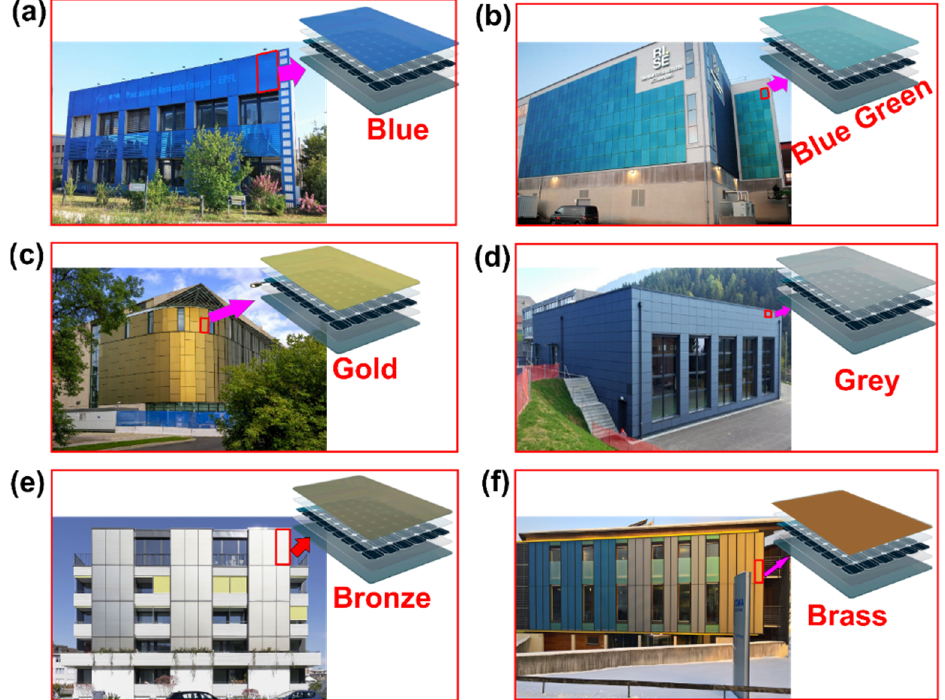
Figure 12. Kromatix TM technology-based PV modules and their applications. ( a ) Retro fi tt ed building of Swiss Federal Institute of Technology of Lausanne (EPFL) with blue modules (reproduced and modi fi ed with permission from Ref. [107]), ( b ) blue-green BIPV wall made by the Swedish Research Institute (RISE) in Bors, Sweden (reproduced and modi fi ed with permission from Ref. [107]), ( c ) BIPV façade by gold PV panels of the Red River College Innovation Center, at Winnipeg, Canada (use with the permission; copyright. SolarLab.dk and Garry Kopelow) [108], ( d ) grey BIPV of the school gymnasium in Leysin, Swi tz erland (reproduced and modi fi ed with permission from Ref, [111]), ( e ) bronze colored BIPV façade in a residential building in Zurich, Swi tz erland (reproduced and modi fi ed with permission from Ref. [114]), and ( f ) Doma Solartechnik Headquarters in Sa tt eins, Austria (reproduced and modi fi ed with permission from Ref.[115]).